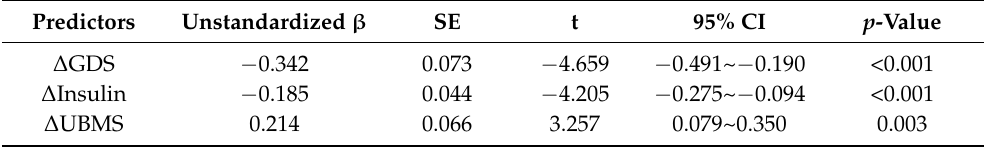
Table 2. Determination of predictors for changed cognitive function after an exercise intervention.